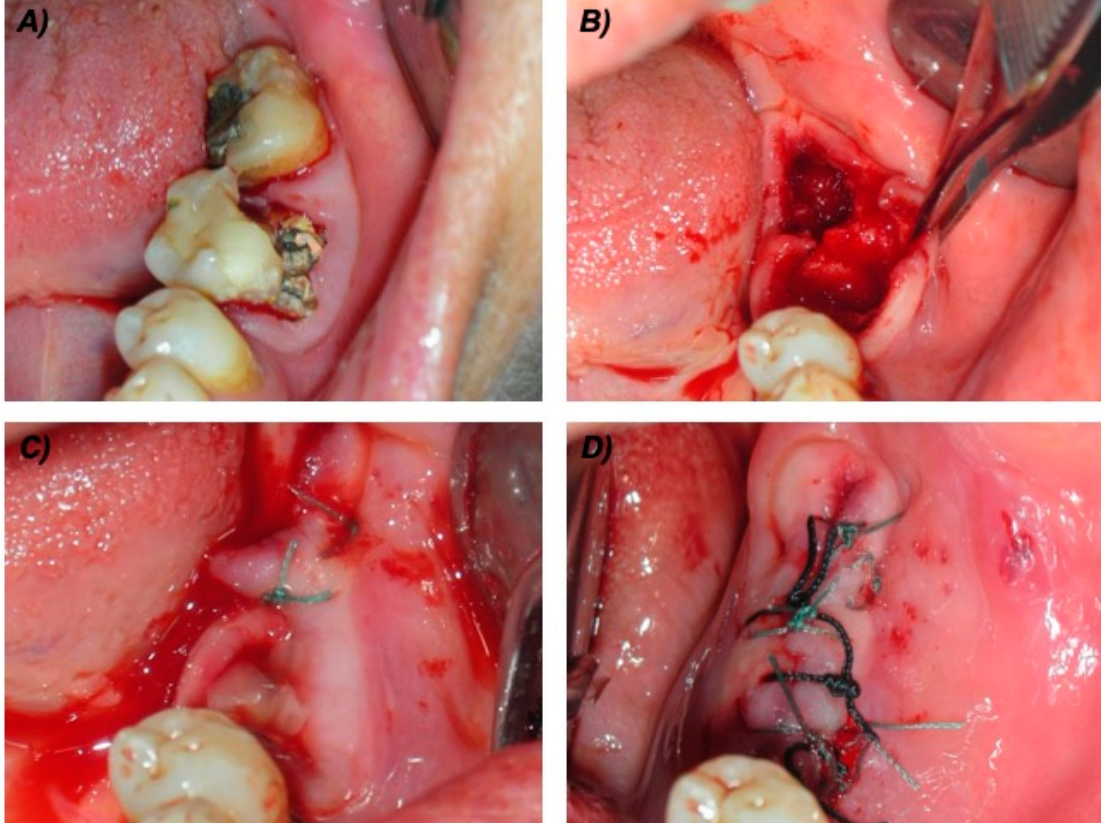
Figure 1. Surgical technical procedures in one cancer (ONC) patient taking intravenous bisphosphonates. ( A ) Pre-operative view of the two compromised teeth. ( B ) Intra-operative view after teeth extraction, bone curettage and osteoplastic procedures. ( C ) Packed platelet rich-plasma (PRP). ( D ) Sutures.